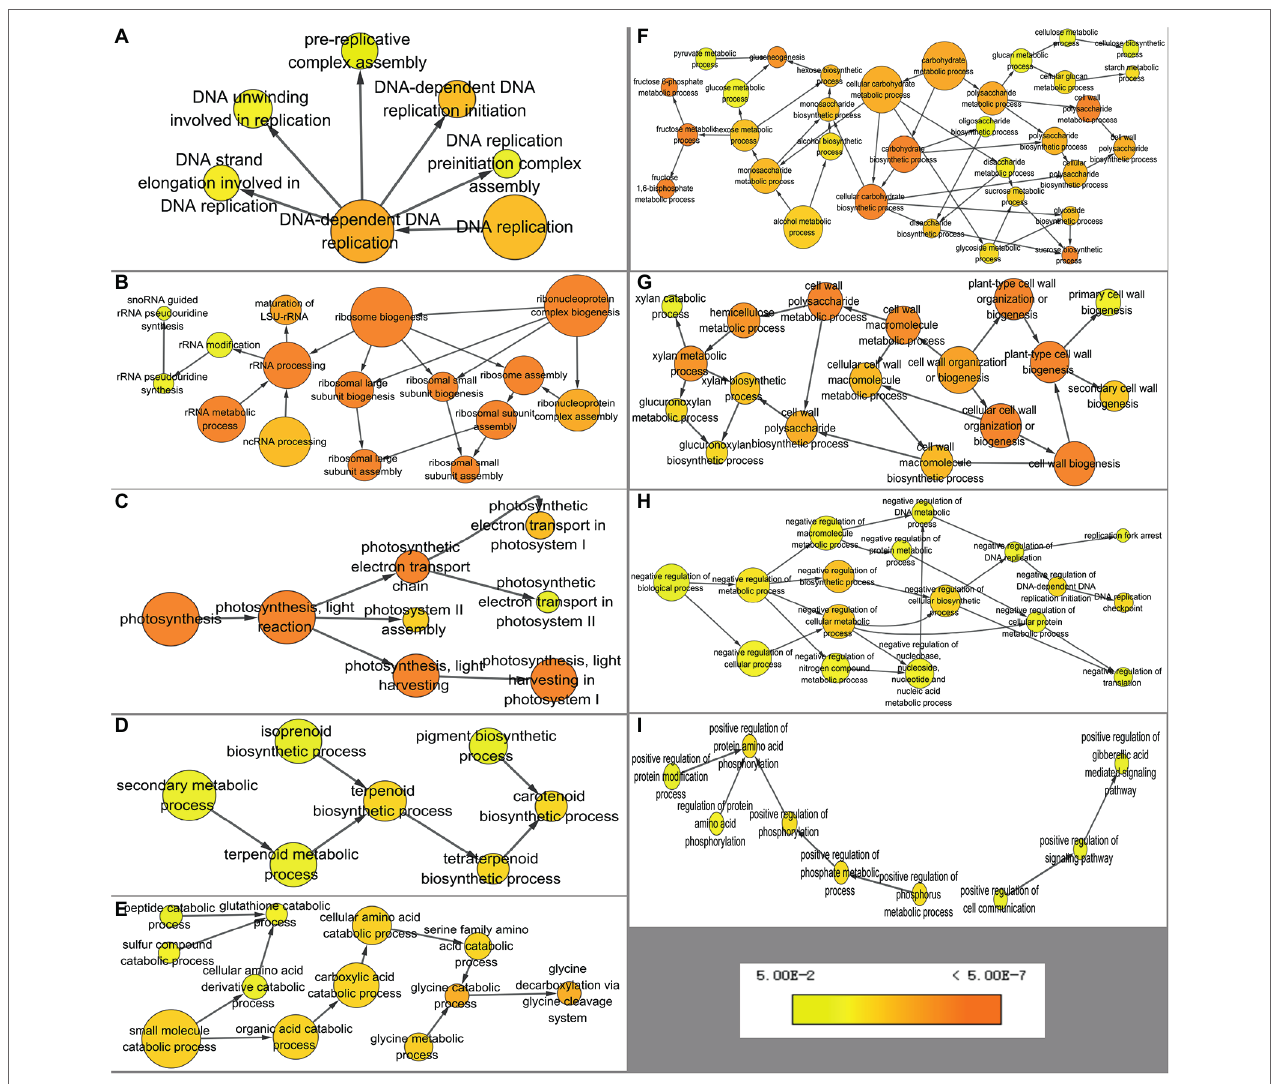
FIGURE 3 | Overrepresented GO (gene ontology) terms of differentially expressed genes annotated by BiNGO separated into nine groups. (A) DNA replication, (B) ribosomal biogenesis, (C) photosynthesis, (D) carotenoid biosynthesis, (E) catabolism of amino acids, (F) carbohydrate metabolism, (G) cell wall organization or biogenesis, (H) negative regulation, and (I) positive regulation. Color of a node represents the corrected p -value, with the scale ranging from yellow ( p = 0.01) to dark orange ( p = 0.01 × 10 − 5 ) and size of a node indicates the number of genes